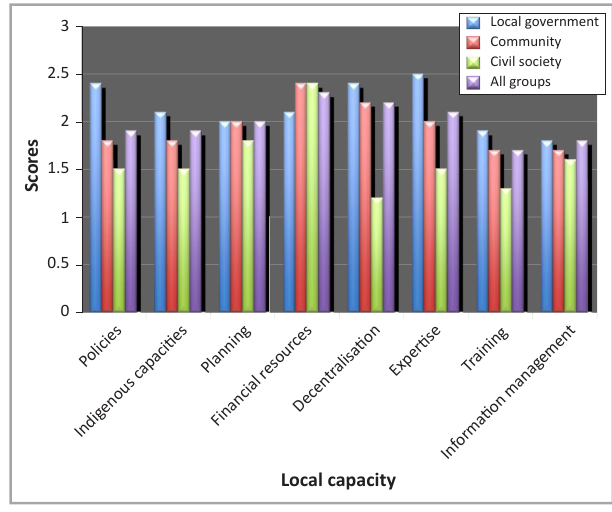
FIGURE 4: Overall mean scores for indicators on local capacity and